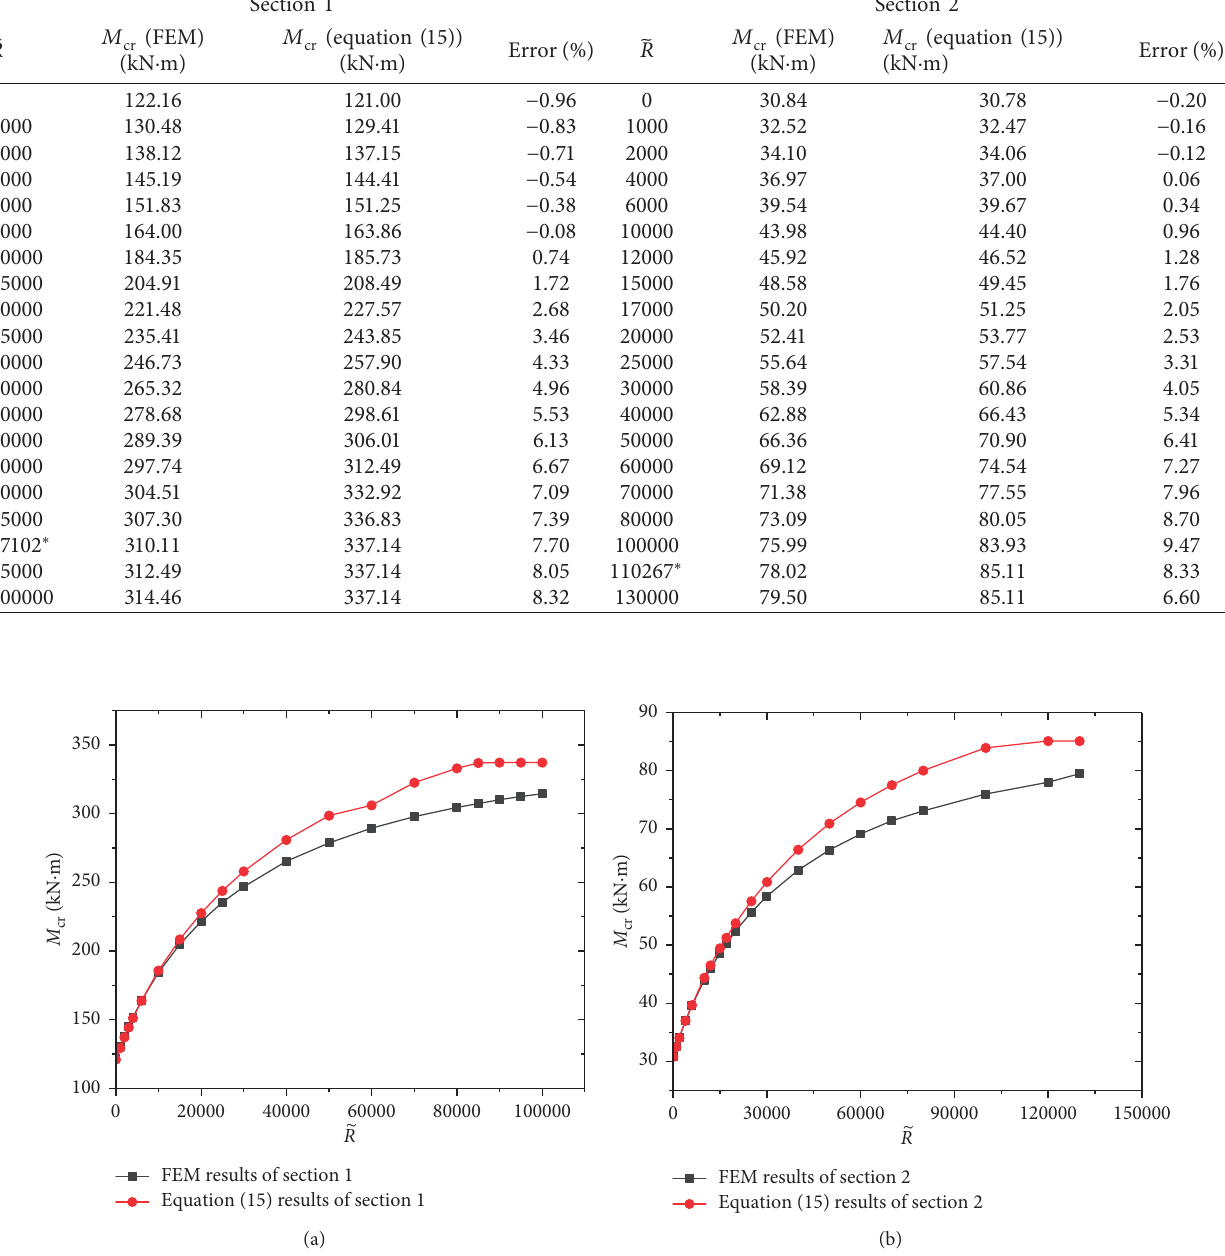
Figure 10: Relationship between critical moments and dimensionless torsional bracing stiffness. (a) Section 1. (b) Section 2.